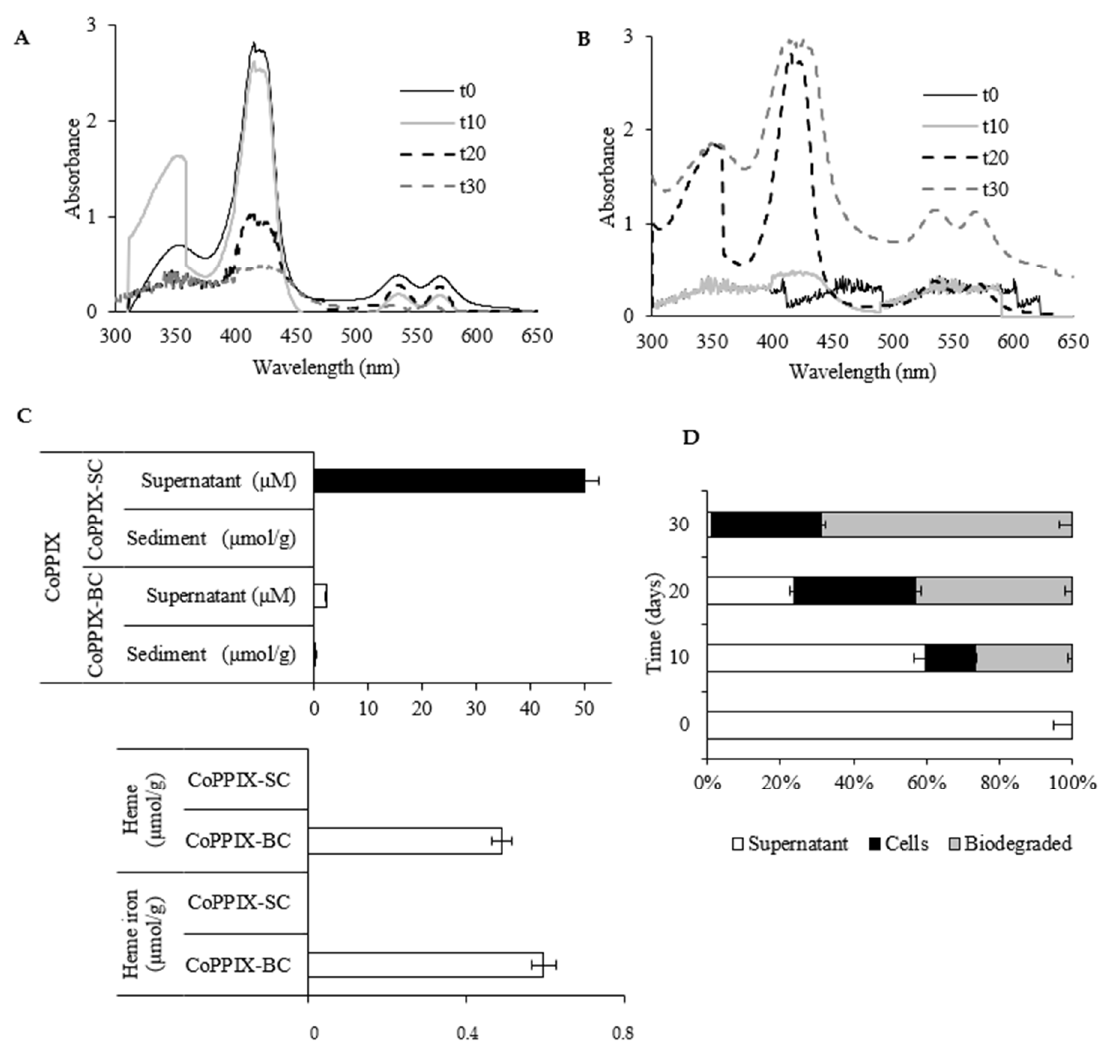
Figure 4. Accumulation of CoPPIX by LM27 strain—UV–Vis spectra of supernatant ( A ) and bacterial cells ( B ); t0–t30: time of the experiment. Concentration of CoPPIX, heme and heme iron in CoPPIX-BC and CoPPIX-SC (µmol/g of biomass or µM (supernatant)) ( C ). Percentage content of CoPPIX in supernatant and cells of CoppIX-BC after 10, 20, and 30 days of cultivation ( D ). Selected ion ( m / z 621) gas chromatogram of CoPPIX and calibration curve for determining the concentra- tion of CoPPIX are presented in Figures S1 and S2, respectively. HPLC-PAD chromatogram of heme is presented in Figure S3A. AED chromatogram of heme is presented in Figure S5. Calibration curves for determining the concentration of heme